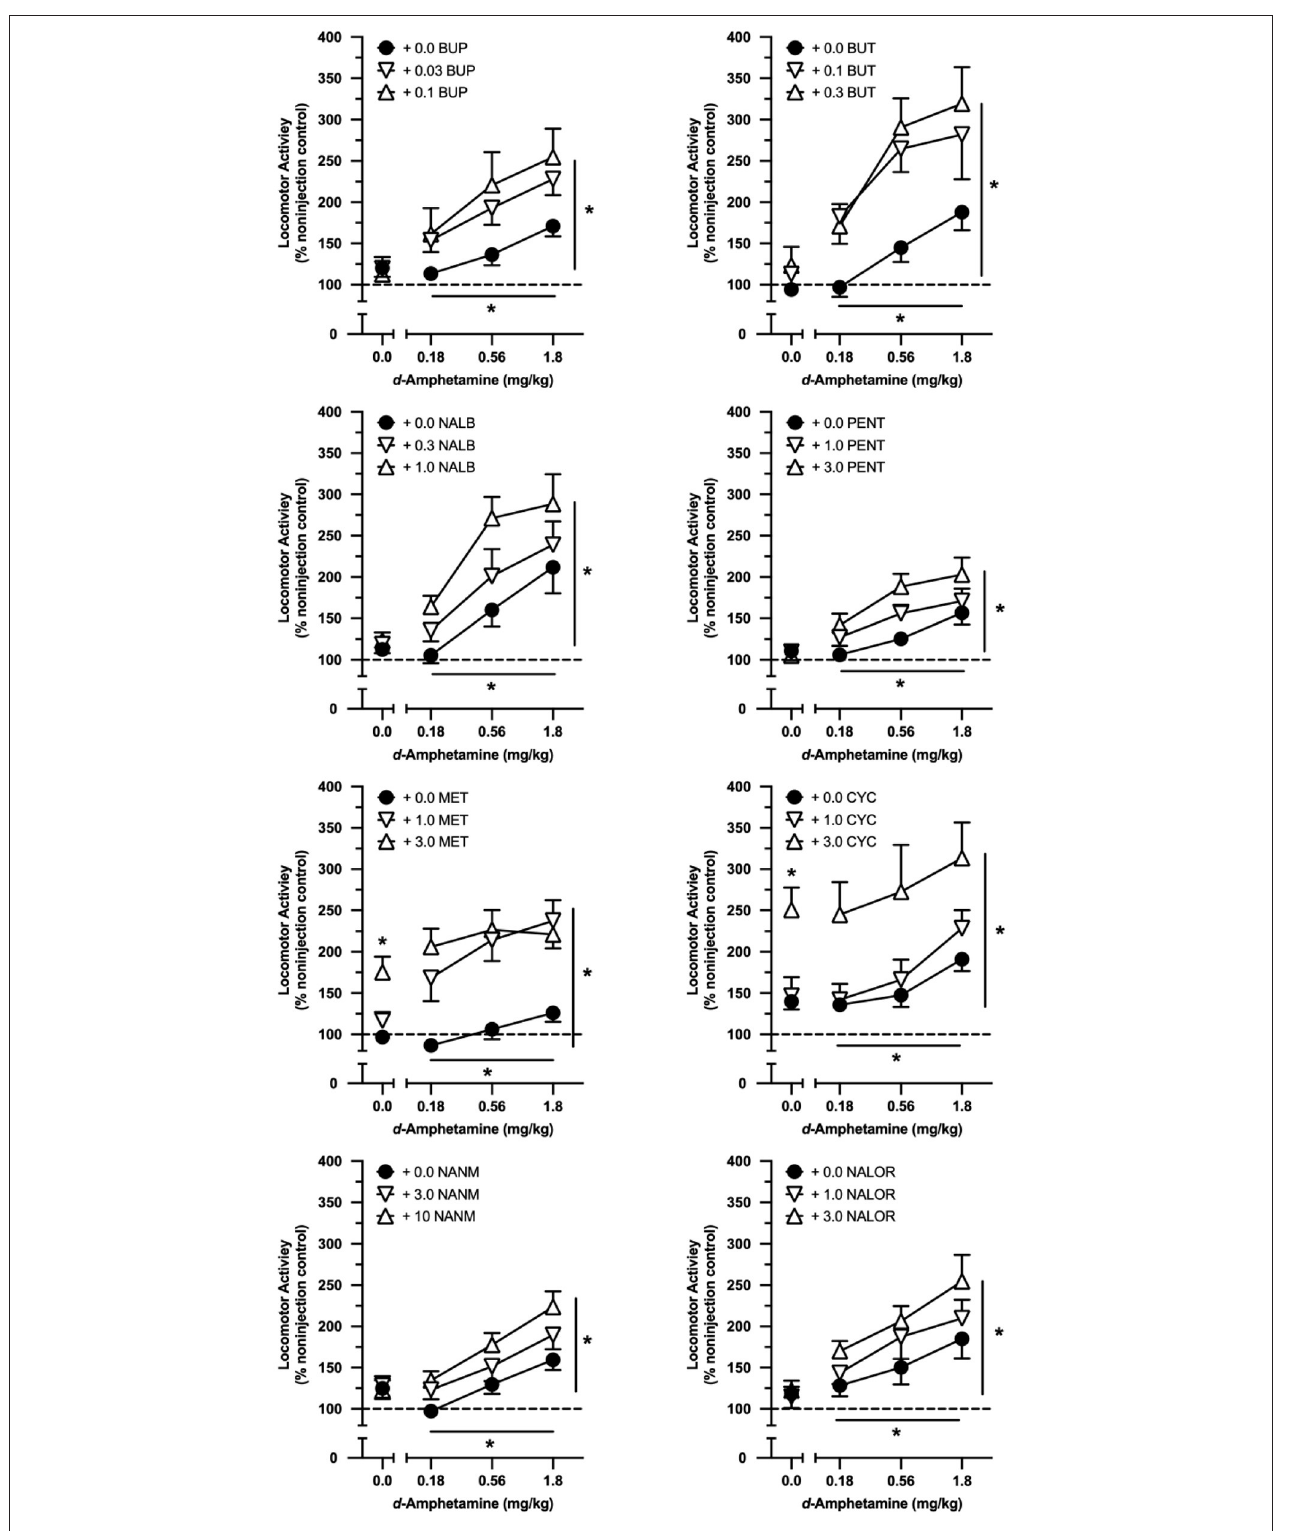
FIGURE 3 | Effects of cumulative doses of d -amphetamine when tested alone and when tested in combination with selected doses of buprenorphine (BUP; n = 9), butorphanol (BUT; n = 10), nalbuphine (NALB; n = 9), (-)-pentazocine (PENT; n = 10), (-)-metazocine (MET; n = 10), (-)-cyclazocine (CYC; n = 10), (-)-NANM (NANM; n = 10), and nalorphine (NALOR; n = 10). Vertical axes reflect locomotor activity expressed as a percentage of non-injection control values. Horizontal axes reflect